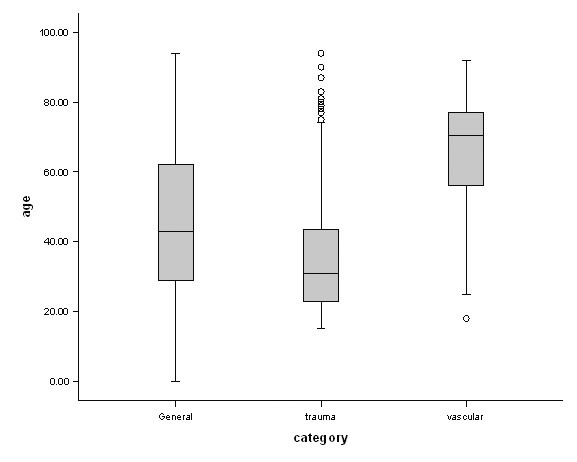
Median age per specialty distribution.